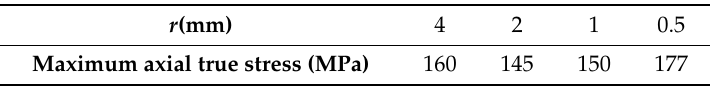
Table 2. Tensile properties of notched axisymmetric specimens.